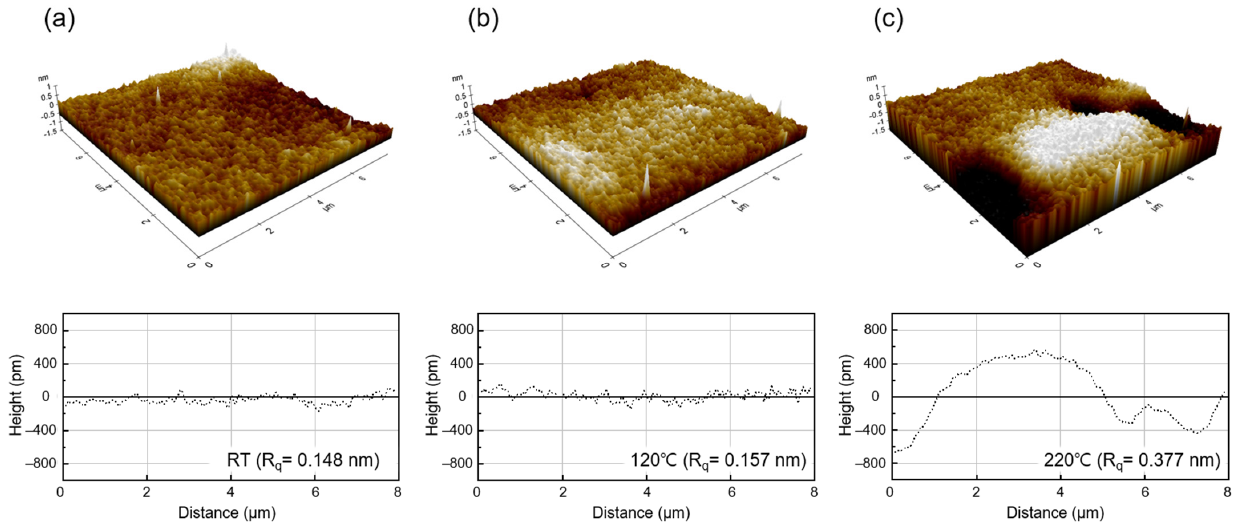
Figure 2. AFM three-dimensional images ( top ) and cross-sectional height profiles ( bottom ) of the surface of the ZTO thin film pre-annealed at ( a ) RT, ( b ) 120 °C, and ( c ) 220 °C.